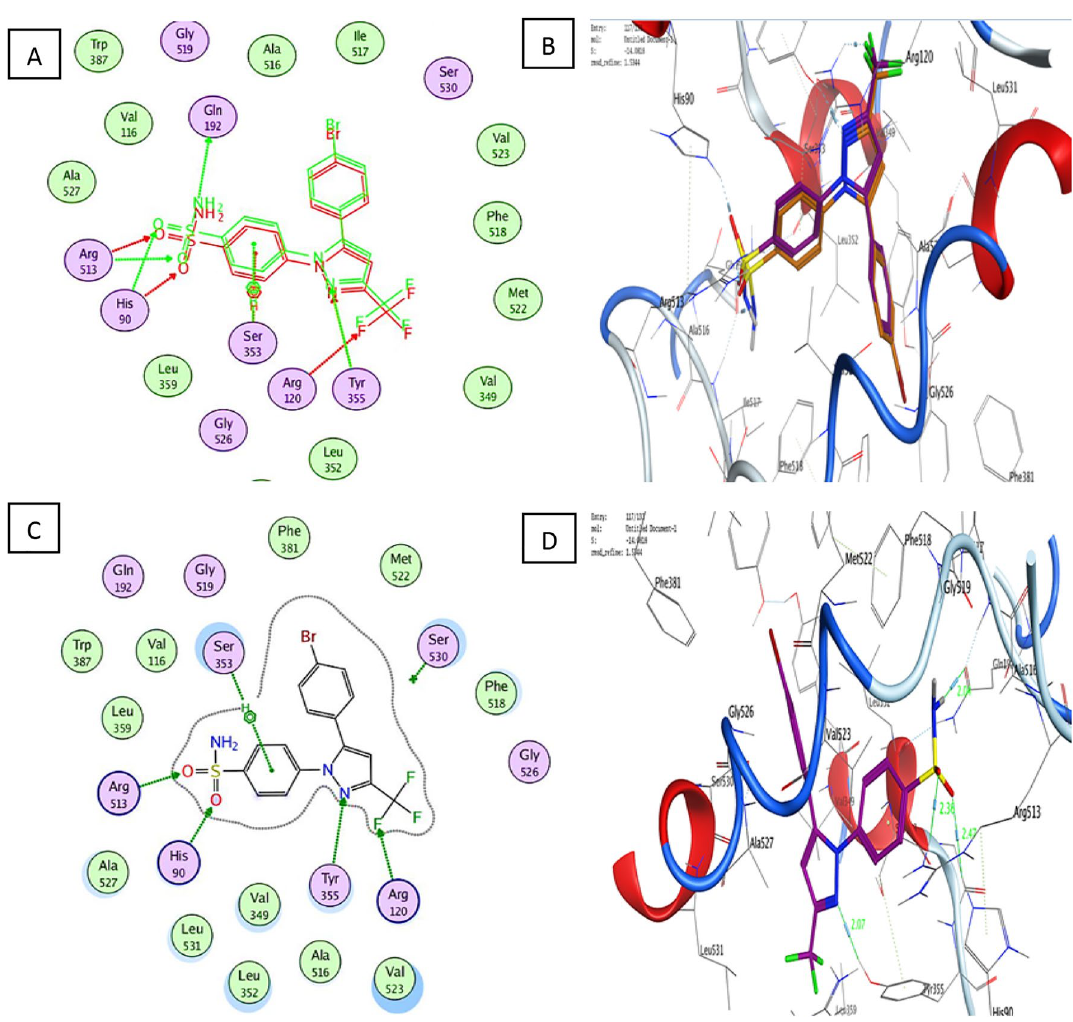
Figure 3. An overlay and binding pattern of S58 into COX-2 active site (PDB 1CX2) 2D ( A , C ) 3D ( B , D ) co-crystalized ligand (Brown), S58